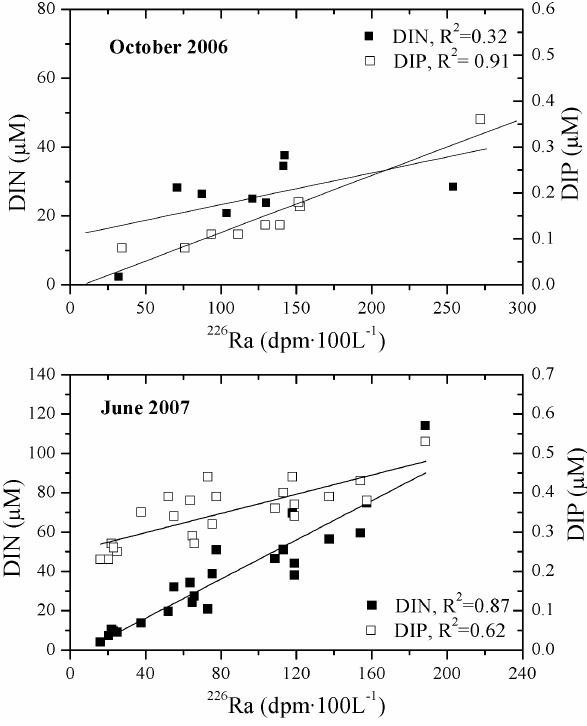
Fig. 12. DIN (solid squares) and DIP (open squares) versus 226 Ra for coastal waters in October 2006 and June 2007